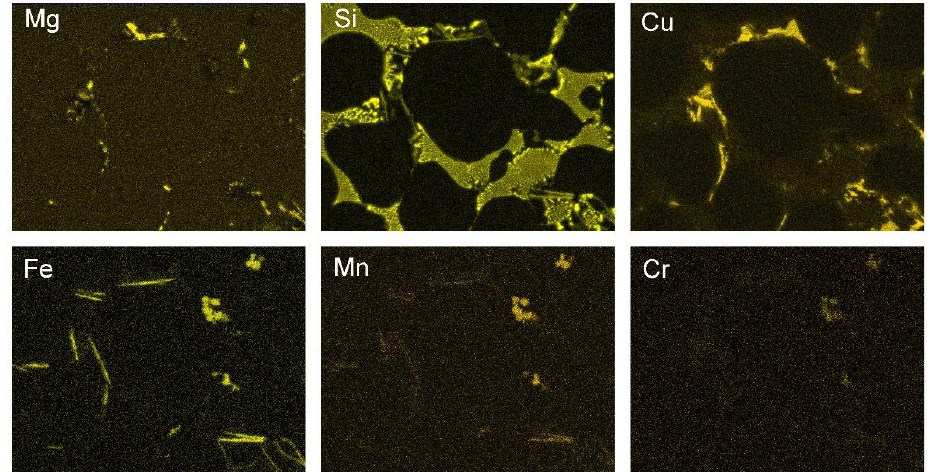
Figure 6. Composition maps by energy dispersive spectroscopy related to the micrograph in Figure 5 and showing the distributions of Mg, Si, Cu, Fe, Mn and Cr elements.